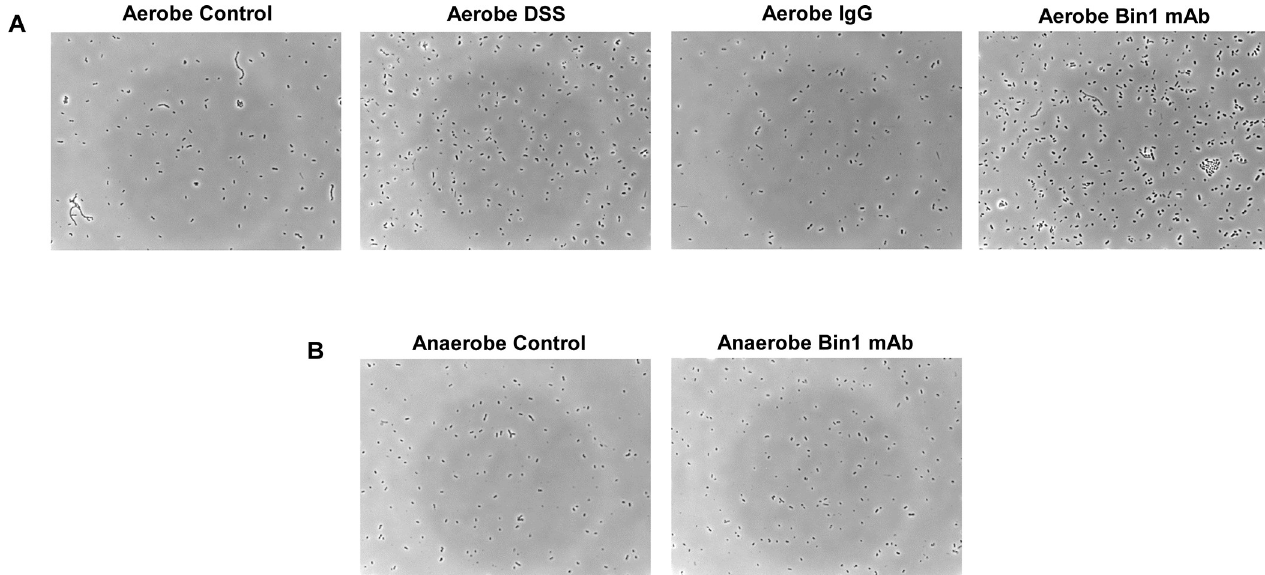
Fig 6. Morphological changes in bacteria of the gut after the treatment with Bin1 mAb. The fecal pellets were collected from untreated control mice, DSS- induced colitis mice, IgG treated mice and Bin 1 mAb treated mice; they were cultured aerobically and anaerobically and the morphology observed under phase contrast microscopy. Fig 6A. Aerobic culture of microorganisms show that the phenotype of Bin1 mAb treated mice has bacteria similar to the control (Phase contrast, 500X) (n = 5; representative image). Fig 6B. Anaerobic culture of microorganisms from fecal pellets were slow growing. There was no change in phenotype of the microorganisms between Bin 1 mAb treated and control groups (Phase contrast, 500X) (n = 5; representative image).